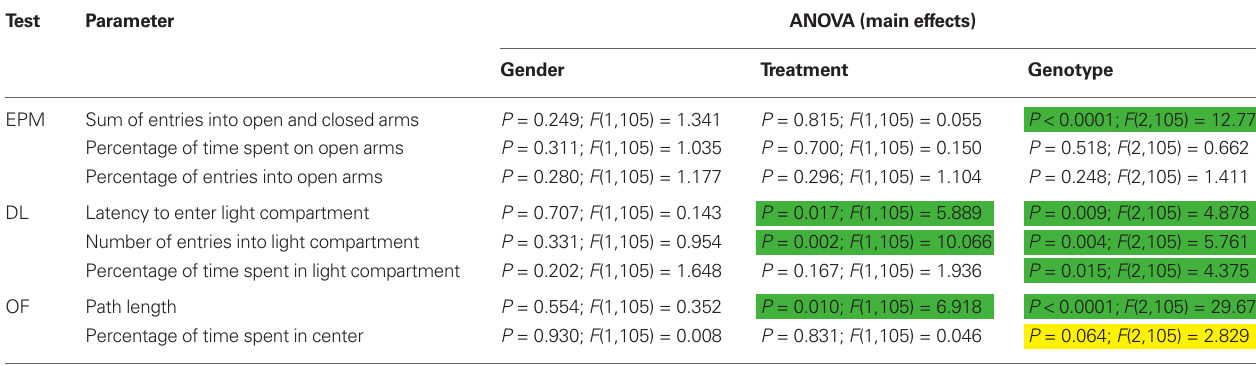
Table 1 | Main effects of gender, treatment and genotype.